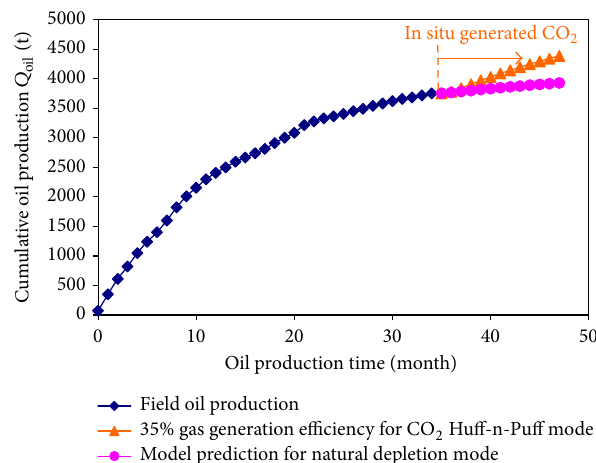
Figure 17: The cumulative oil production in different recovery